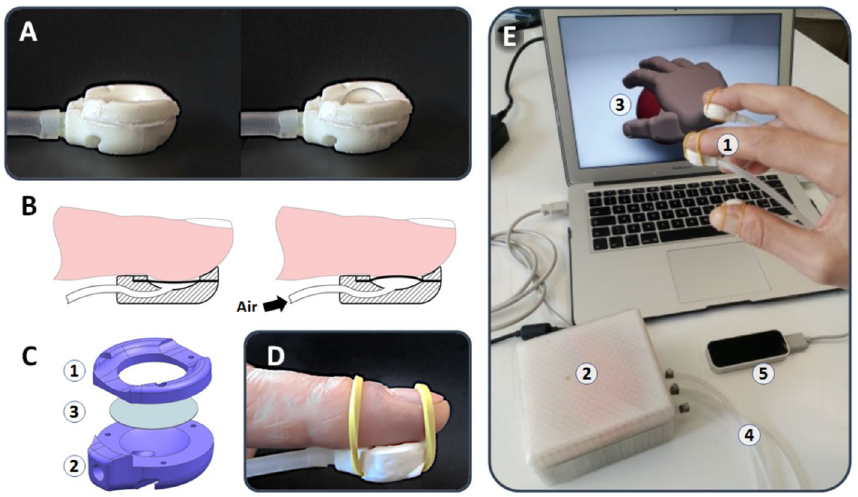
Figure 1. Illustrations of the softness display and example of a possible use. ( A ) Optical images of a prototype display, showing a deformation of the membrane upon pressurisation. ( B ) Sectional schematic drawings showing the principle of operation of the device as a display of softness: pressurisation deforms the membrane, so as to cause an indentation of the fingertip’s skin and an increase of the contact area, which are two essential tactile stimuli concurring to the perception of softness. ( C ) Exploded drawing of the device, showing that it consists of two plastic parts (1)–(2), which sandwich and laterally constrain an elastomeric membrane (3). ( D ) Optical image of the prototype display secured to a fingertip by means of elastic bands; the weight of the display was 3 g. ( E ) Example of use of the device: three fingertip-mounted displays (1) are simultaneously and independently controlled by the electro-pneumatic unit (2), to render the softness of a computer-generated deformable ball (3); connections to the unit are via thin elastomeric tubing (4), stretchable and not just flexible, so as to minimise impact on finger movements; the latter are monitored in real time by an optical sensor (LEAP Motion, USA) arranged below the hand (5); information captured by the sensor is used to continuously detect the intended motor action (extent of ball squeezing) and return both a visual feedback on the screen and a related tactile feedback on the